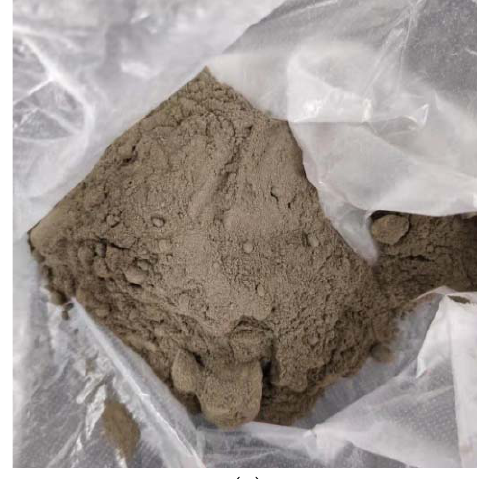
Figure 1. Images of FBA ( a ) and BBA ( b ). Table 1. Chemical composition of dead ‐ burned MgO and BAs as determined by XRF.